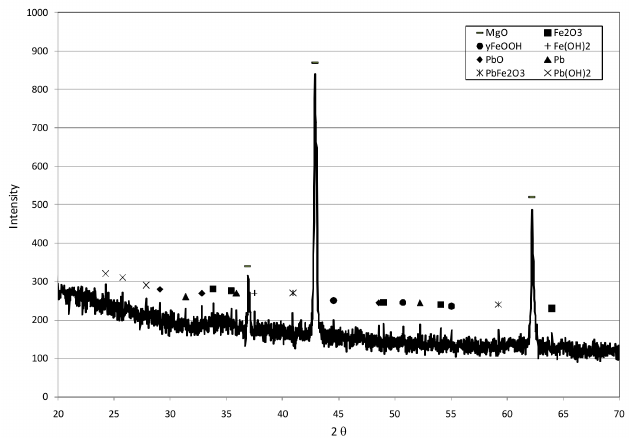
Figure 13. XRD diffractogram of MgO_nZVI after the test conducted with Pb 2+ concentration of 70 mg/L and initial pH = 5.